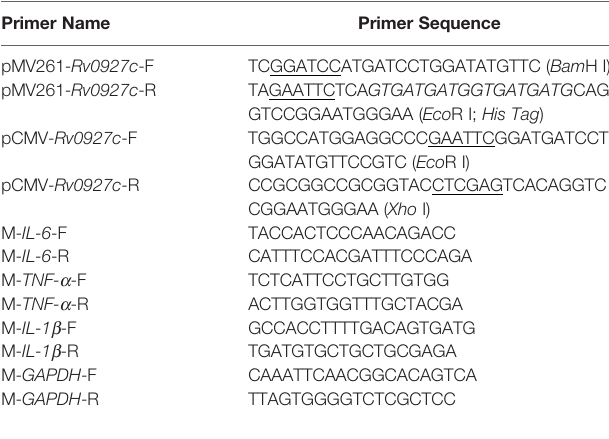
TABLE 1 | Primers used in this